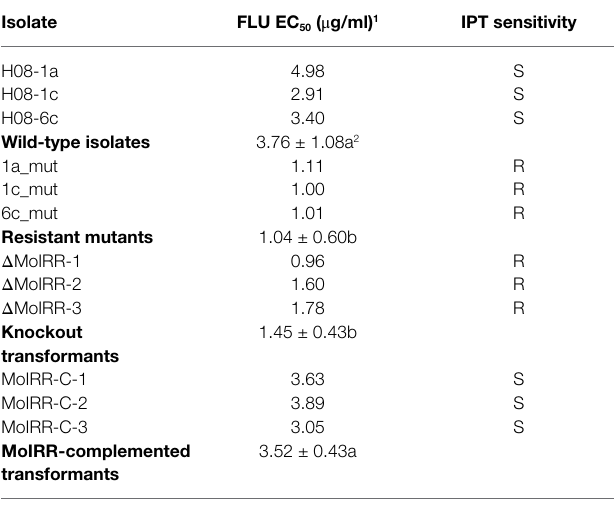
TABLE 3 | Introduces isoprothiolane (IPT)-resistant mutants and MoIRR knockout transformants showed increased susceptibility to fludioxonil (FLU).